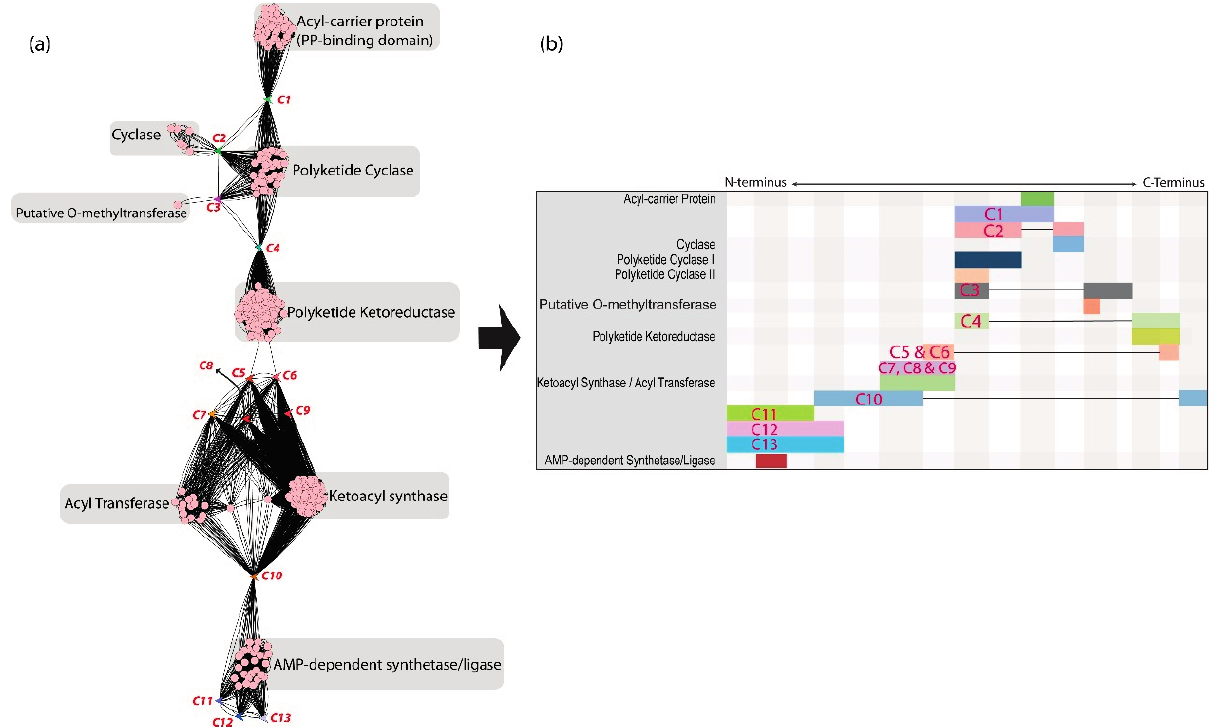
Figure 1. ( a ) Giant Connected Component (GCC) uniting 423 proteins. Composite proteins are indicated using the labels C1–C13. Communities within the GCC are labelled with their consensus function. Occasionally, members of a community are present in two different isoforms (e.g., “Polyketide Cyclases” are long form and short form); ( b ) A “lego diagram” of the block structure of the proteins and how gene remodelling provides a path connecting all the proteins in this GCC. Homologous protein parts are aligned in the same column. The rows are the different kinds of genes. Occasionally, in order to facilitate lining the blocks up, it was necessary to split the proteins. In those cases, black lines join contiguous protein